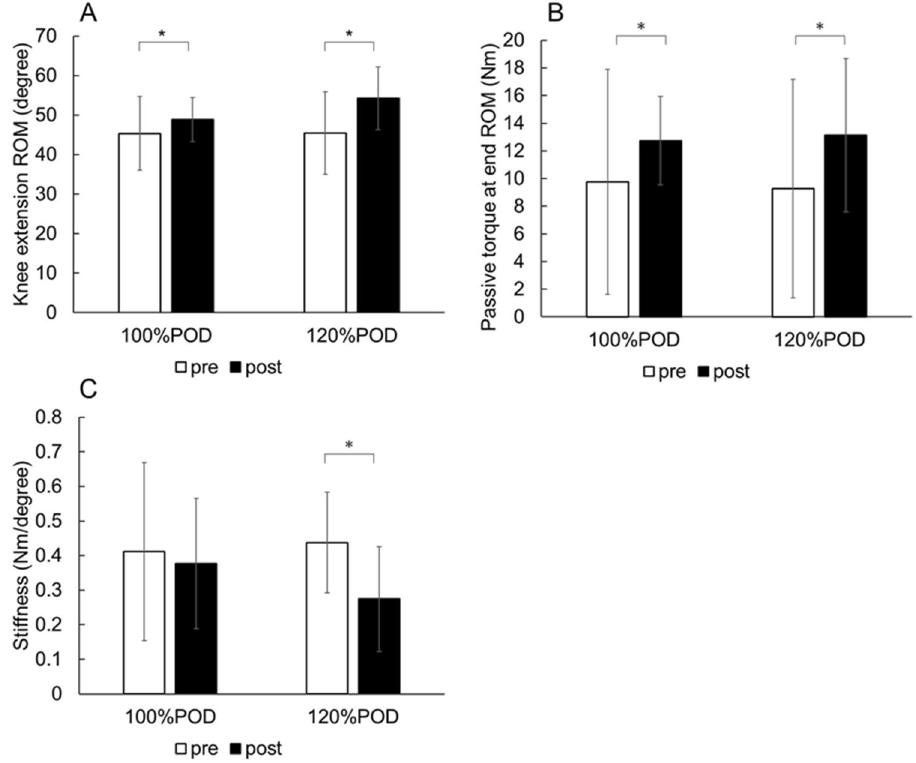
Figure 2. Changes in knee extension ROM ( A ), passive torque at end ROM ( B ), and muscle–tendon unit stiffness ( C ). Data were represented as mean ± standard deviation. * p < 0.01 (pre versus post). ROM: range of motion.